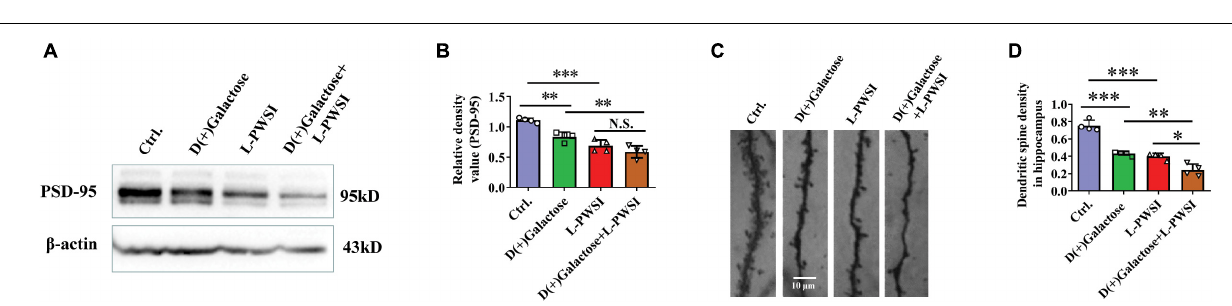
maze new arm test was performed to detect episodic